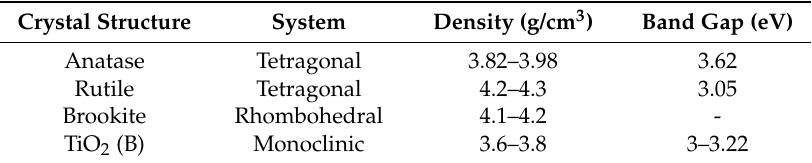
Table 3. Some parameters of the four main polymorphs of TiO 2